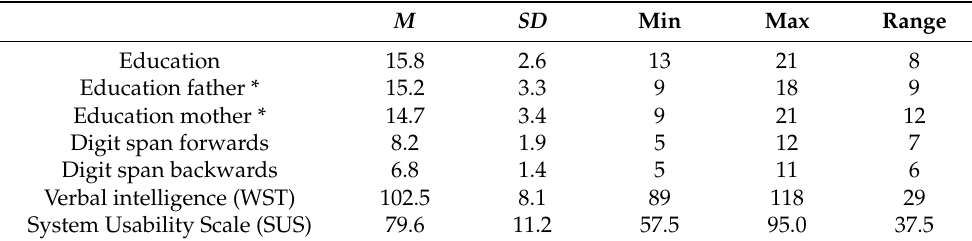
Table 1. Descriptive